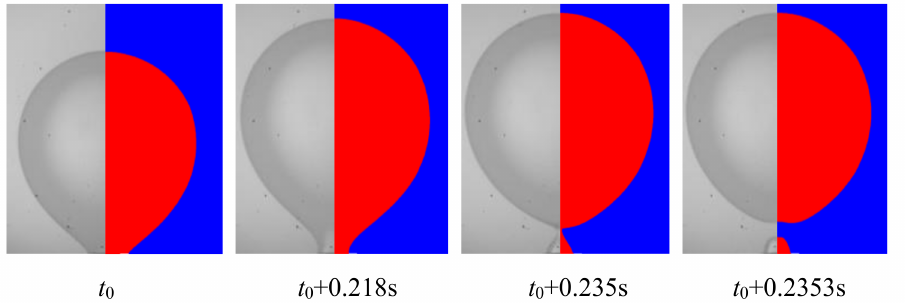
Figure 4. Case validation ( q d = 90 mL / s, We = 0.027, Bo =